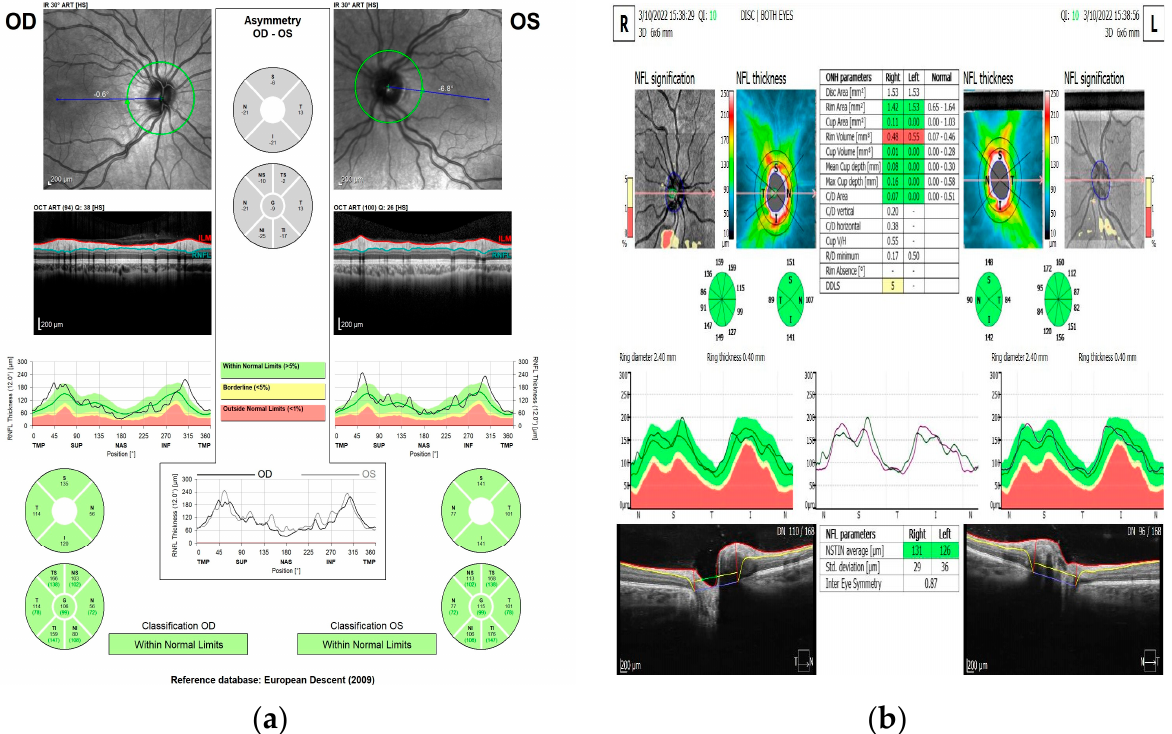
Figure 1. ( a ) Spectralis SD-OCT scans of retinal nerve fiber layer thickness map. ( b ) SOCT Copernicus REVO NFL thickness profile. [Personal database].